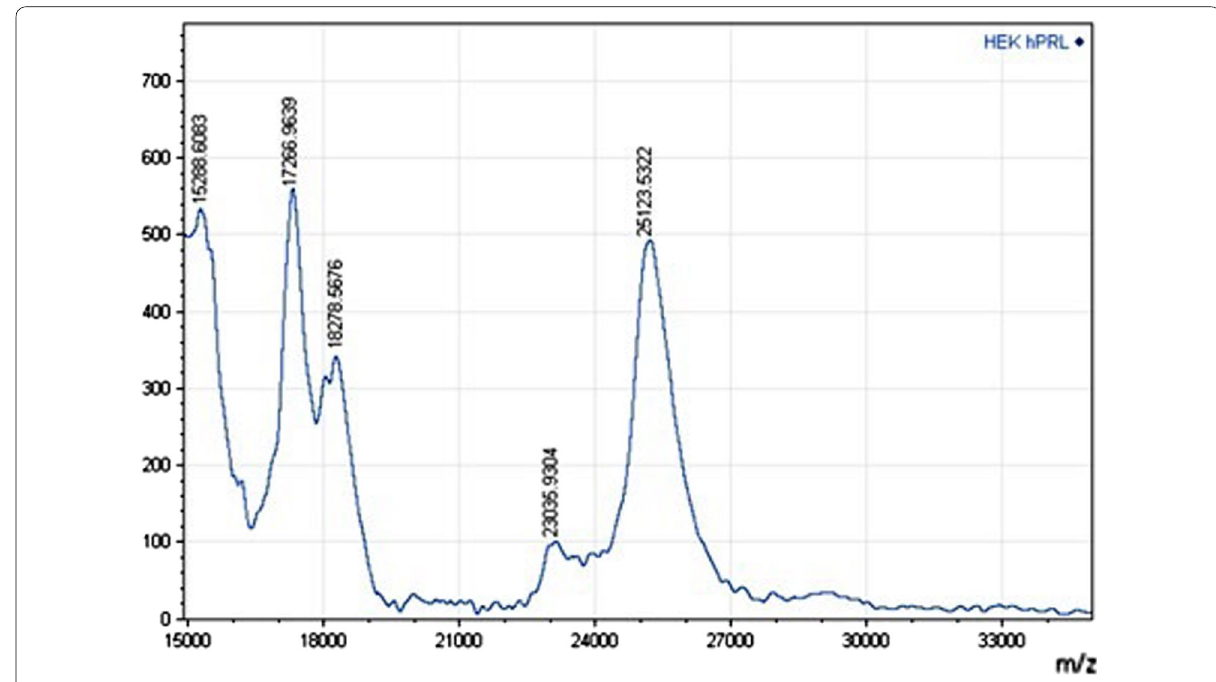
Fig. 4 HEK293-G-hPRL molecular mass determination by MALDI–TOF-MS